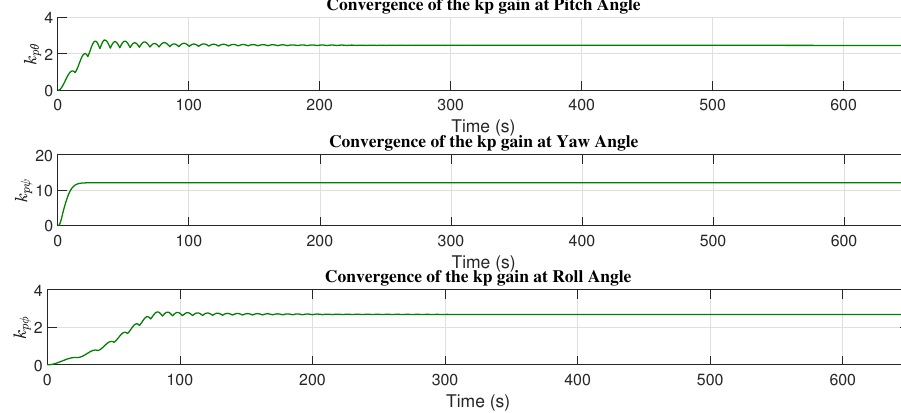
Figure 21. Convergence ˆ k p with MIT rule with twisting (MIT-Twisting).